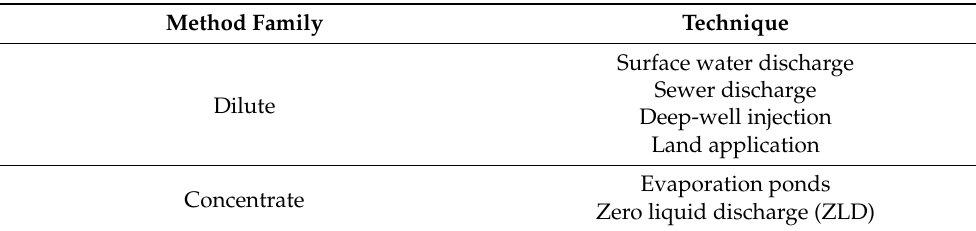
Table 12. Classification of current brine disposal